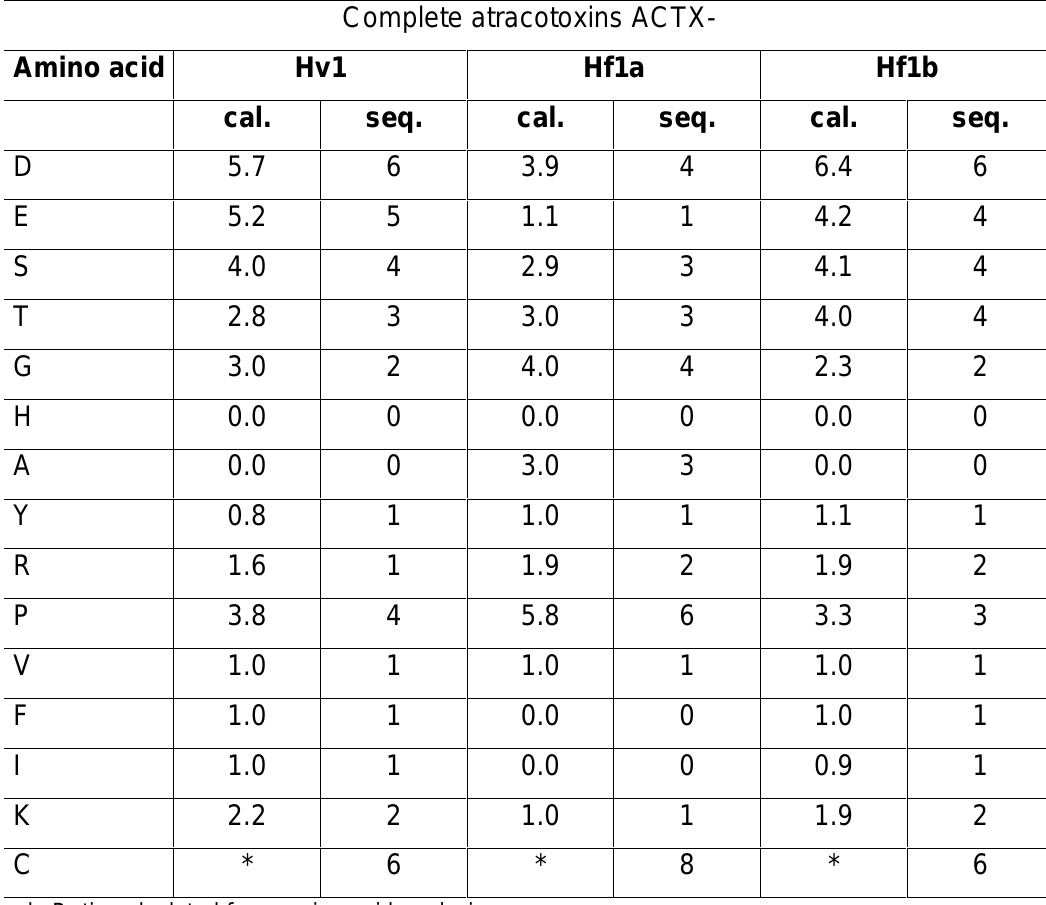
Table 2.2: Amino acid composition of the toxins. Complete atracotoxins ACTX- Amino acid